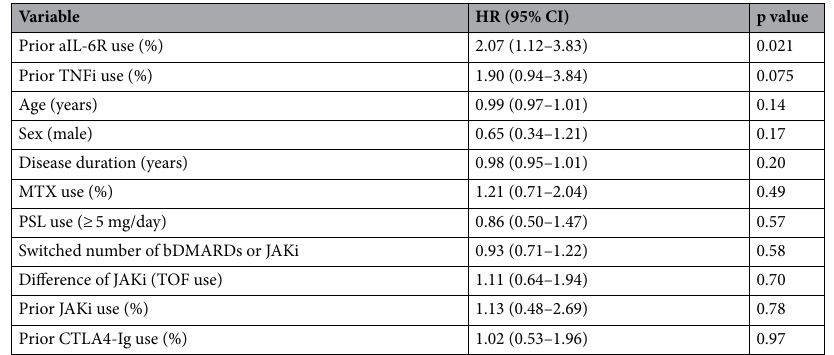
Table 2. Cox proportional hazard analysis for the risk factors of treatment discontinuation due to lack of effectiveness. HR hazard ratio, CI confidence interval, aIL-6R anti-interleukin-6 receptor, TNFi tumour necrosis factor inhibitors, MTX methotrexate, PSL prednisolone, bDMARDs biological disease-modifying antirheumatic drugs, JAKi Janus kinase inhibito, TOF tofacitinib, CTLA4-Ig cytotoxic T lymphocyte-associated antigen-4-Ig.